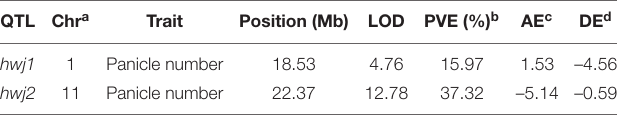
a Chromosome. b Percentage of variance explained by the QTL. c Additive effects of the marker calculated as (average of LTH-average of T65)/2. d Dominance effect calculated as average of heterozygotes-(average of LTH + average of T65)/2.